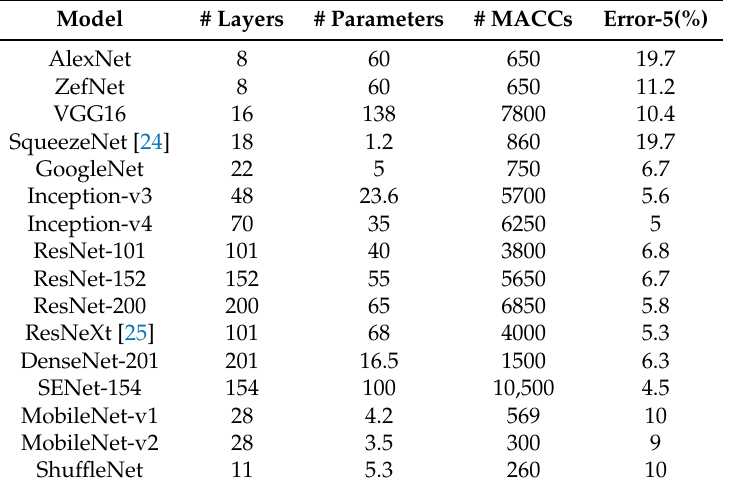
Table 2. Complexity and accuracy of known convolutional neural network (CNN) networks.